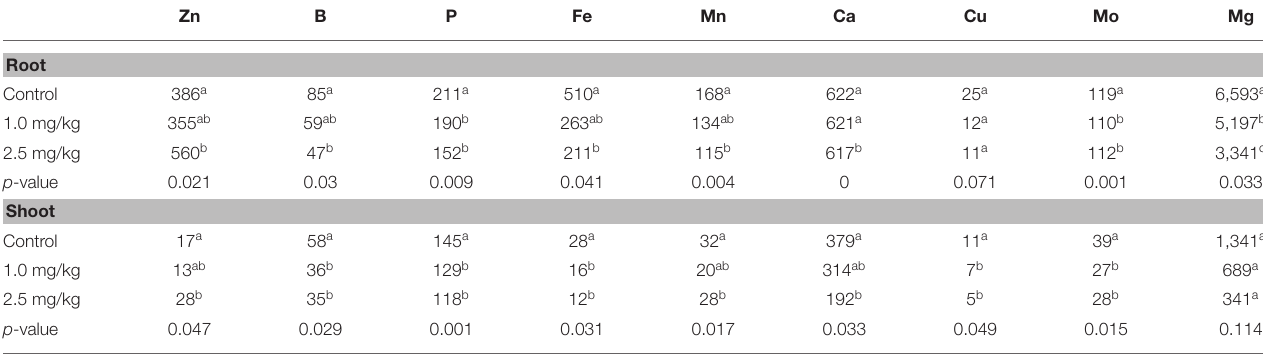
TABLE 2 | Effects of Cd on mineral nutrient accumulation in snapdragon tissues (mg/kg, DW). Zn B P Fe Mn Ca Cu Mo